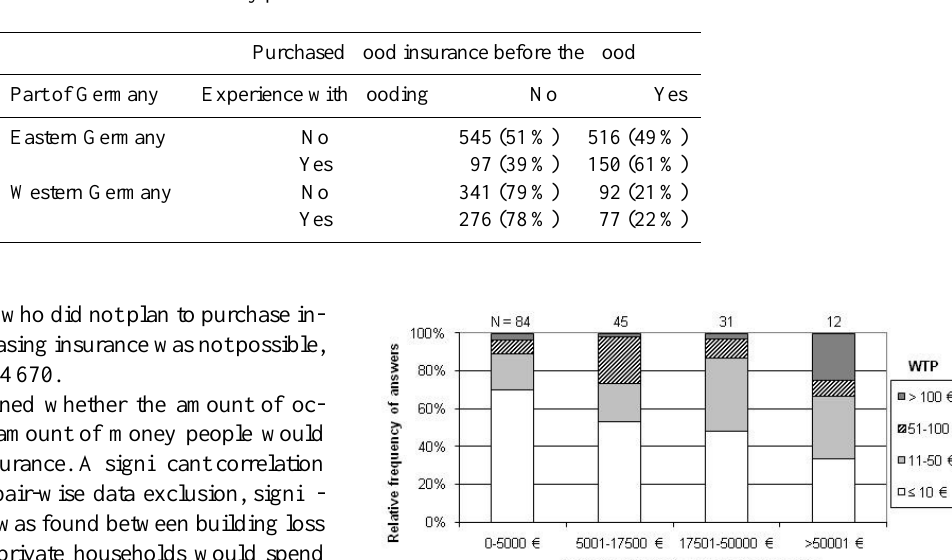
Table 3. Cross tabulation (in absolute values and row percentage) of private households in Eastern and Western Germany, who experienced, and who did not experience, a flood and whether or not they purchased flood insurance before the flood event.